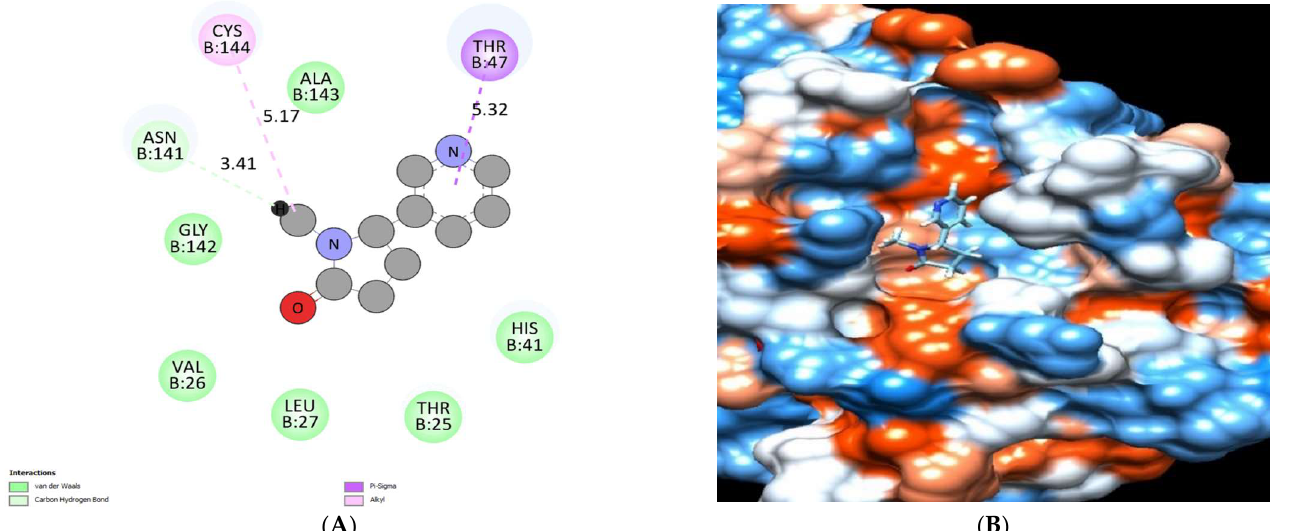
Figure 16. The binding mode of cotinine exhibited an energy binding of −6.12 kcal/mol against HCo- V 229E main protease. Hydrogen bonds are represented in green and pi interactions are described in pink lines ( A ), with a mapping surface showing cotinine occupying the active pocket of HCo-V 229E main protease ( B ).